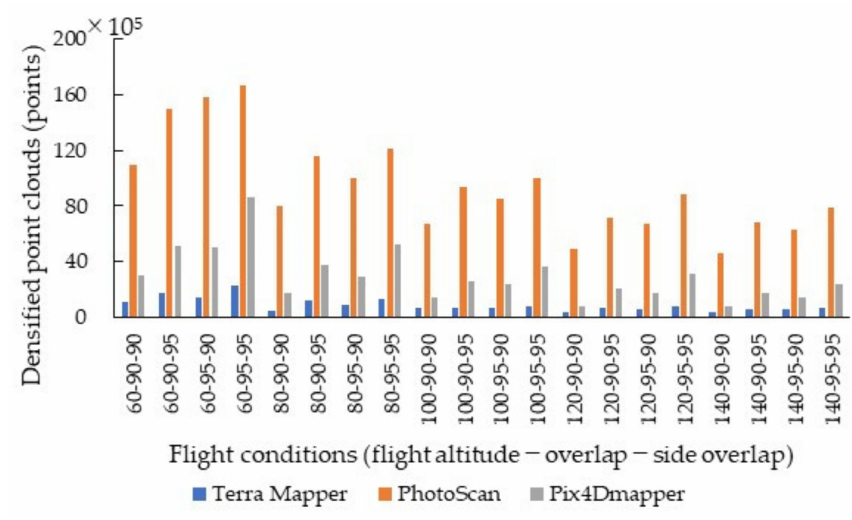
Figure 5. Number of densified point clouds in the image generated by each SfM software.